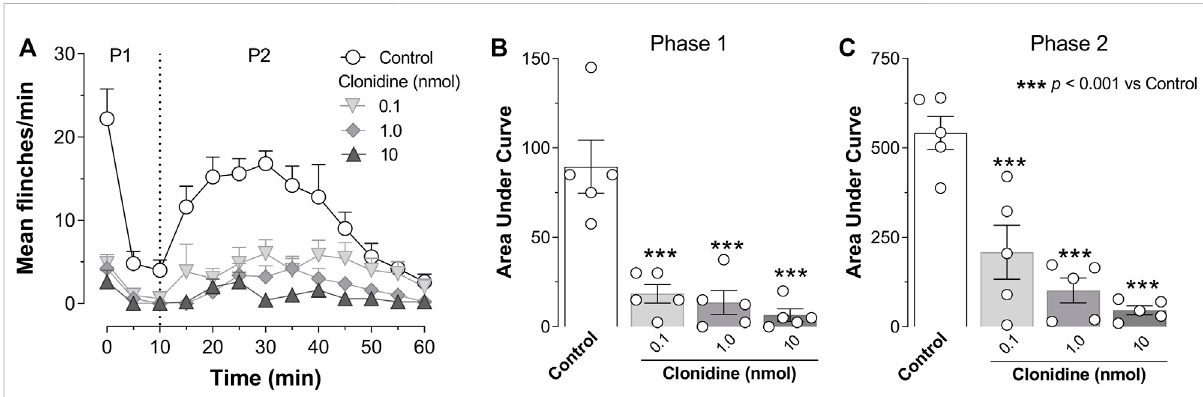
FIGURE 2 Intrathecal (i.t.) clonidine ( α 2A/2B/2C -adrenoceptor agonist) inhibits behavioral nociception. (A) Flinching number over time during phase I (P1) andphaseII(P2)ofthemeannumberperminuteof fl inchesobservedafteri.t.,clonidine(0.1,1,and10 nmol; n =5eachdose)inratssubmittedtothe 1% formalin test (50 μ l, s.c.). (B,C) show the time course data expressed as thearea under the mean number of fl inches against the time curve (AUC). Clonidine reduced AUC values during both phases (P1, P2), indicating an antinociceptive effect. Clonidine was given 10 min prior to formalin